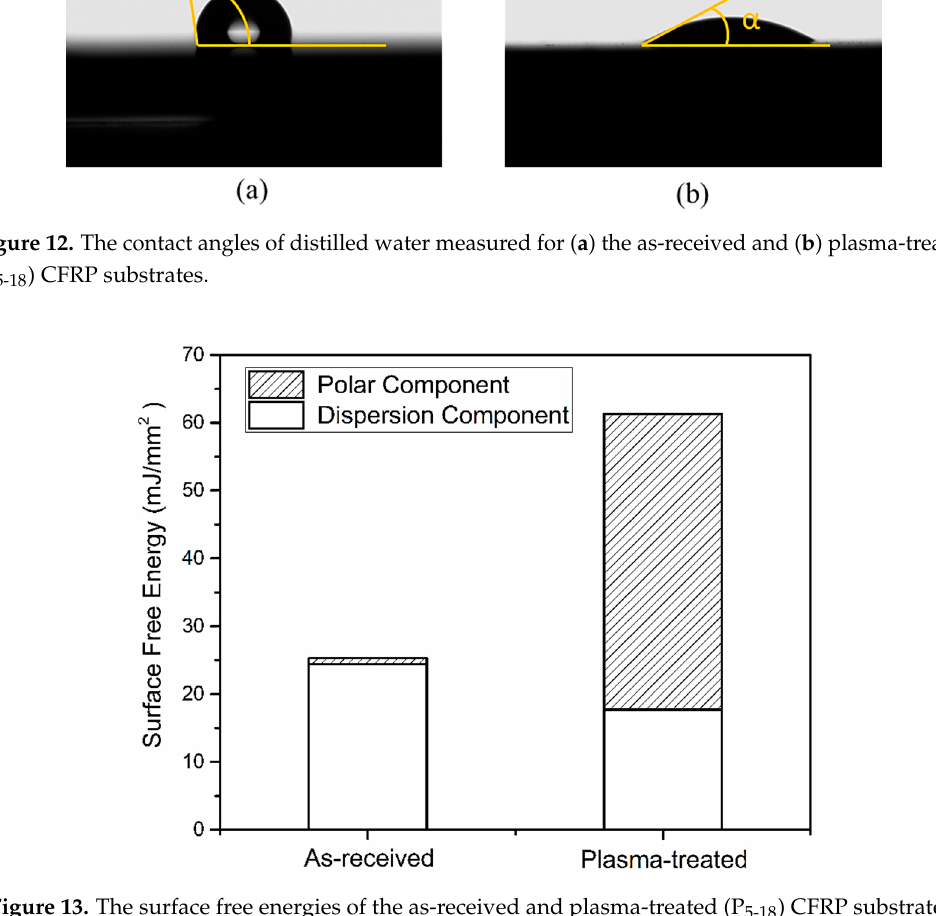
Figure 13. The surface free energies of the as-received and plasma-treated (P 5-18 ) CFRP substrates.